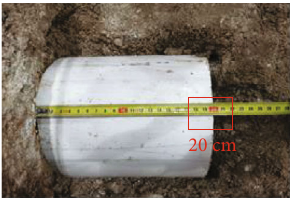
Figure 10: The embedment of the PVC